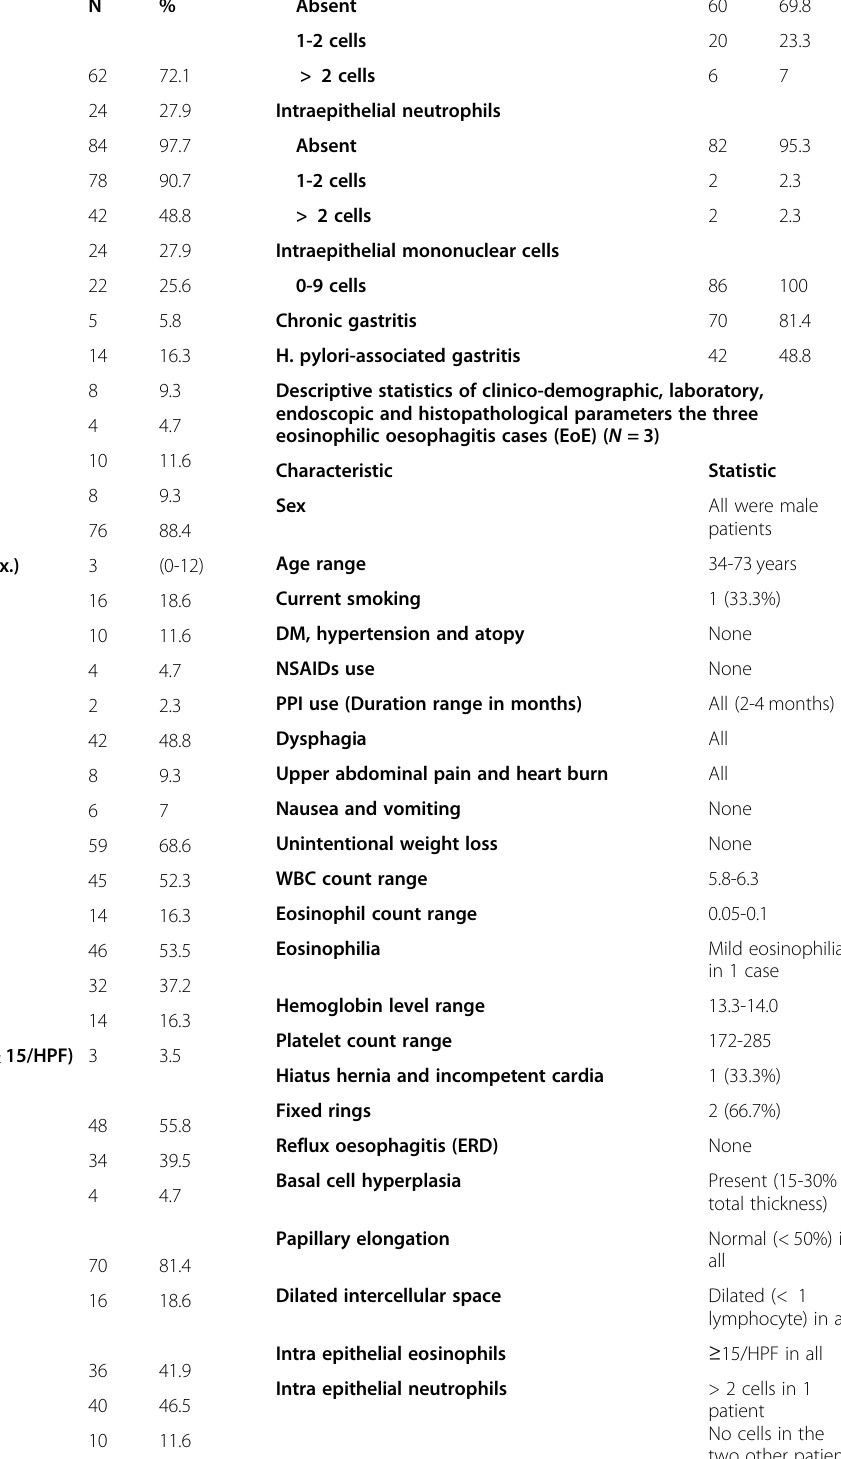
Table 1 Descriptive statistics of demographic,